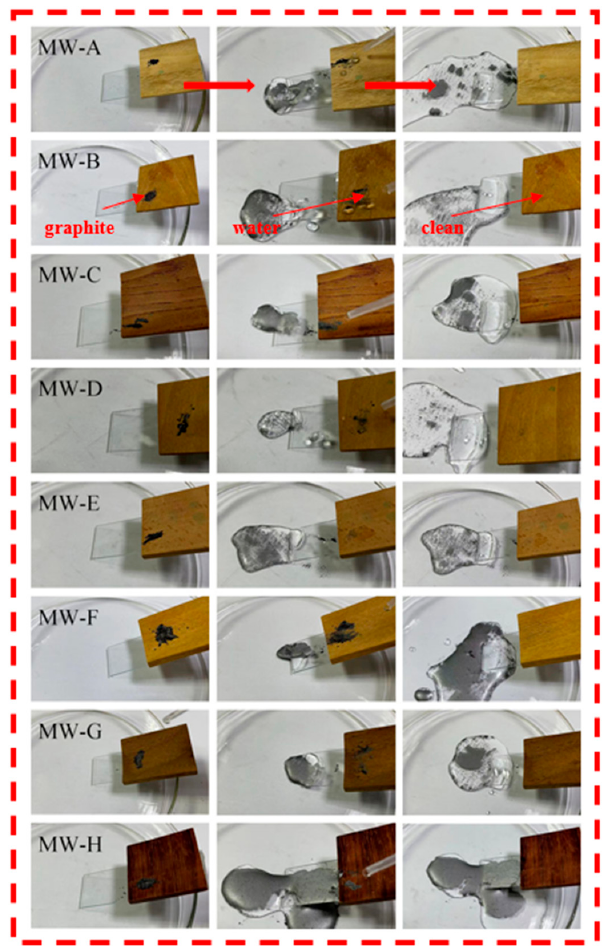
Figure 9. Self-cleaning test of modified wood.